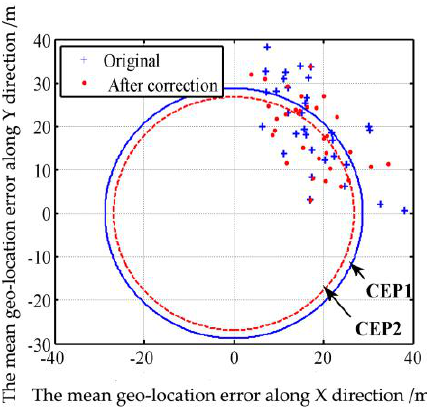
Figure 12. Sample distribution of target location error before and after distortion correction.